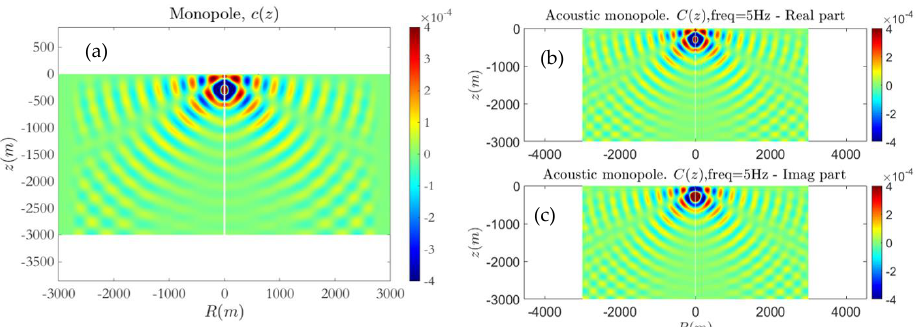
Figure 11. ( a ) The acoustic field obtained using the solution of the FDTD – PML numerical scheme